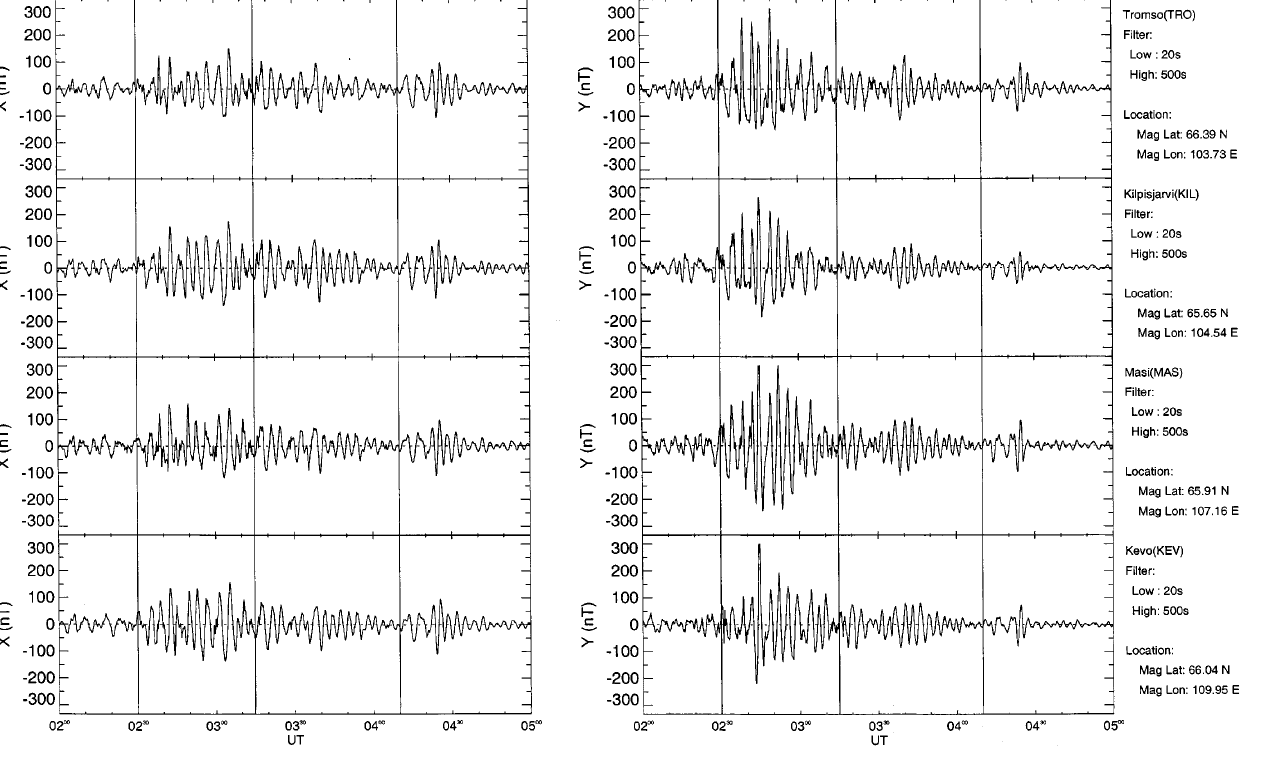
(north-south) are in a and the Y components (east-west) are in b . The vertical lines identify the three separate intervals of ULF wave activity as described in